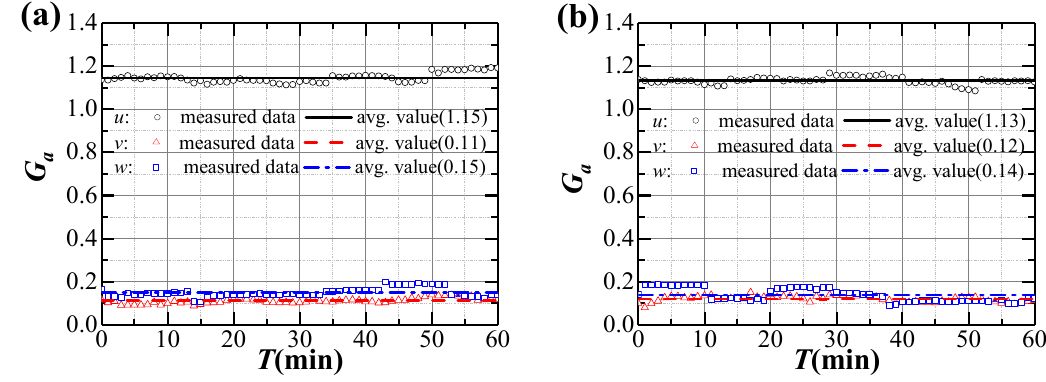
Figure 6. Variation of gust factors during strong winds: ( a ) Typhoon Bailu; ( b ) Strong monsoon event.